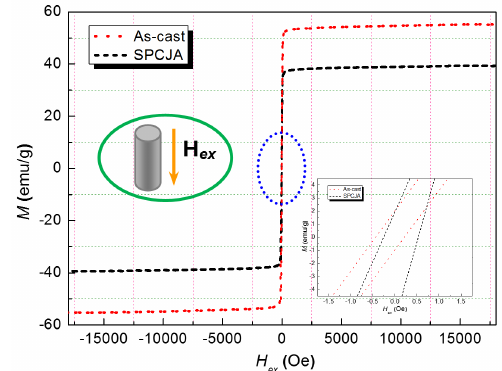
Figure 2. Longitudinal M - H hysteresis loops including a magnified central area of as-cast and SPCJA-ed microwires. The uni-directional arrow indicates the direction of external magnetic field H